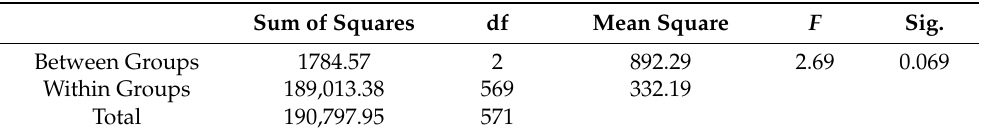
Table 7. Analysis of variance for the three wine brand image clusters regarding average price of bottled wine. Sum of Squares df Mean Square F Sig. Between Groups 1784.57 2 892.29 2.69 0.069 Within Groups 189,013.38 569 332.19 Total 190,797.95 571